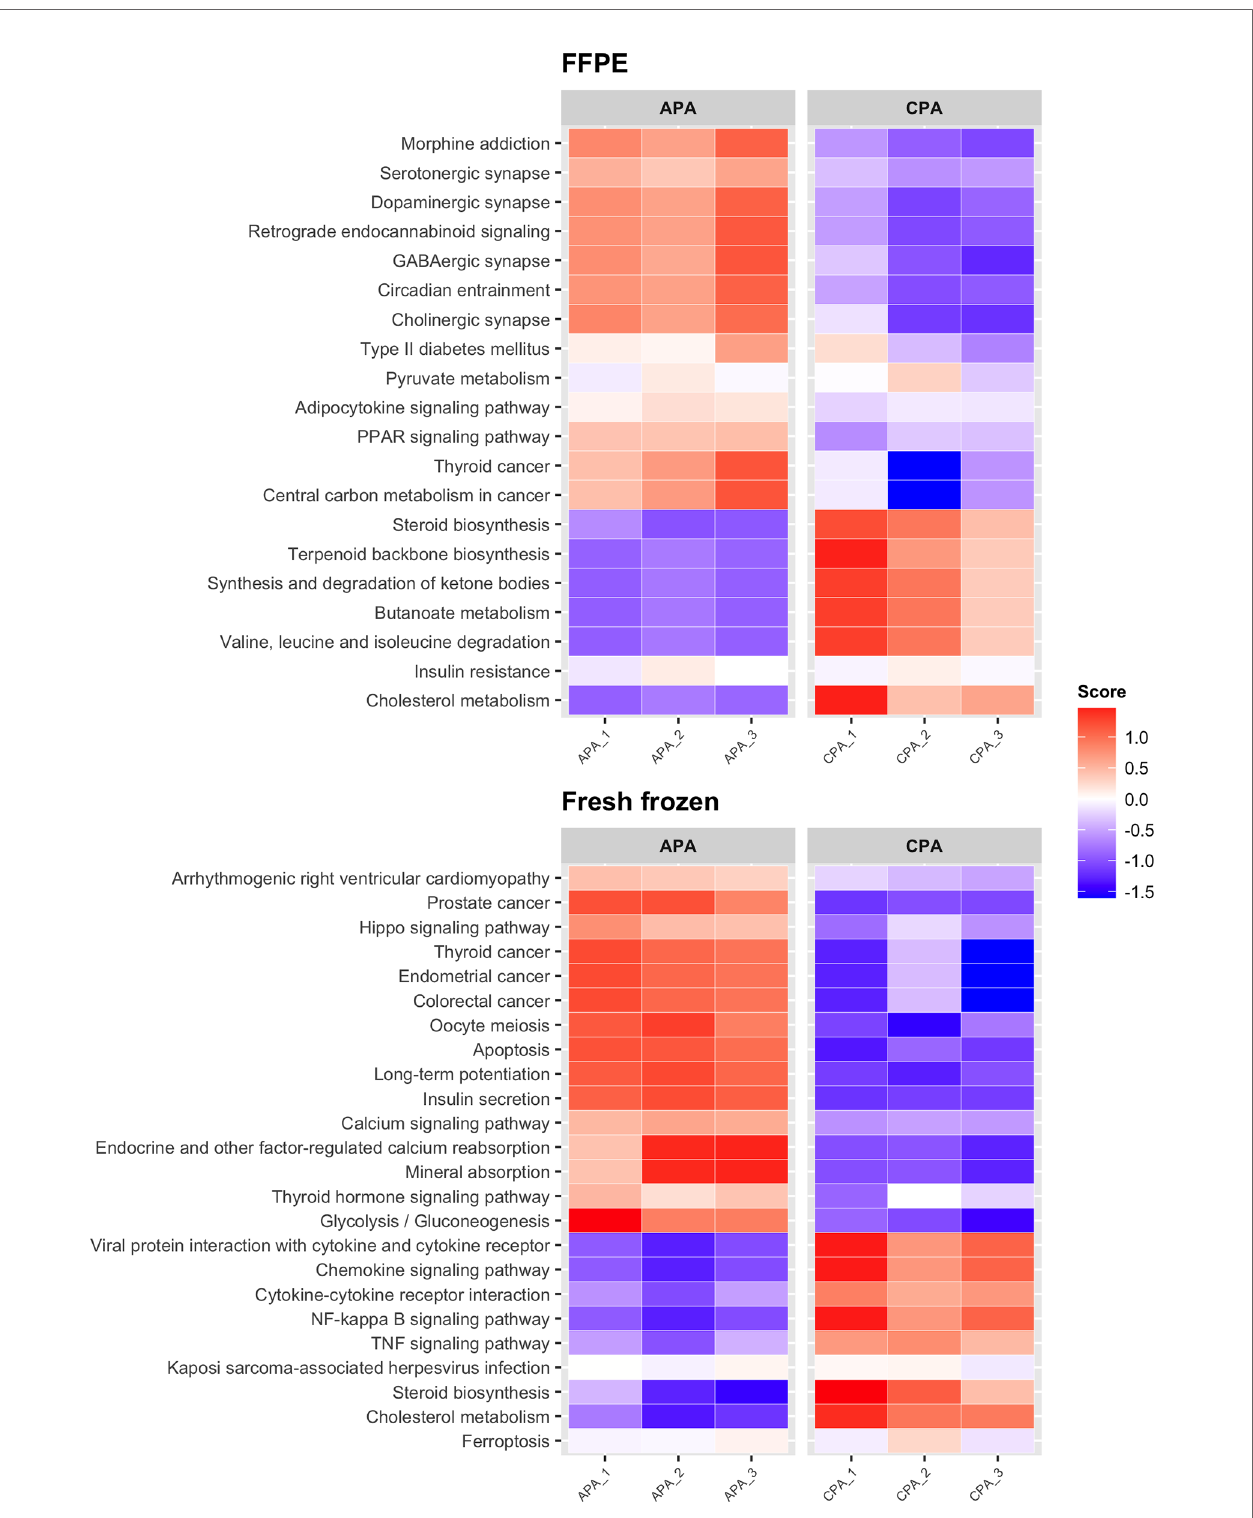
FIGURE 4 | Heatmap showing the results of KEGG pathway analysis of DEGs between APA and CPA by each storage type. Score; the agglomerated z score of each enriched KEGG pathway per sample.